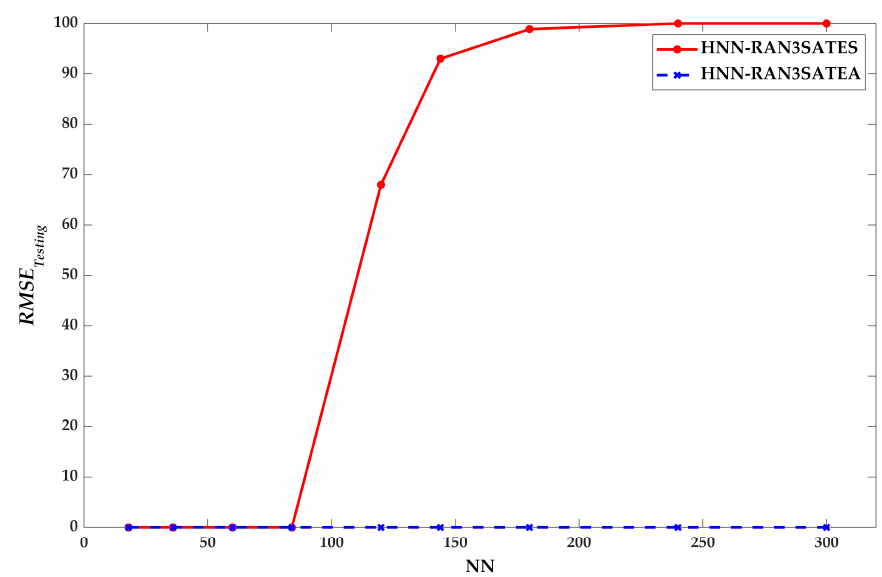
Figure 6. RMSE Testing for HNN-RAN3SAT Figure 6. Testing RMSE for HNN-RAN3SAT model.